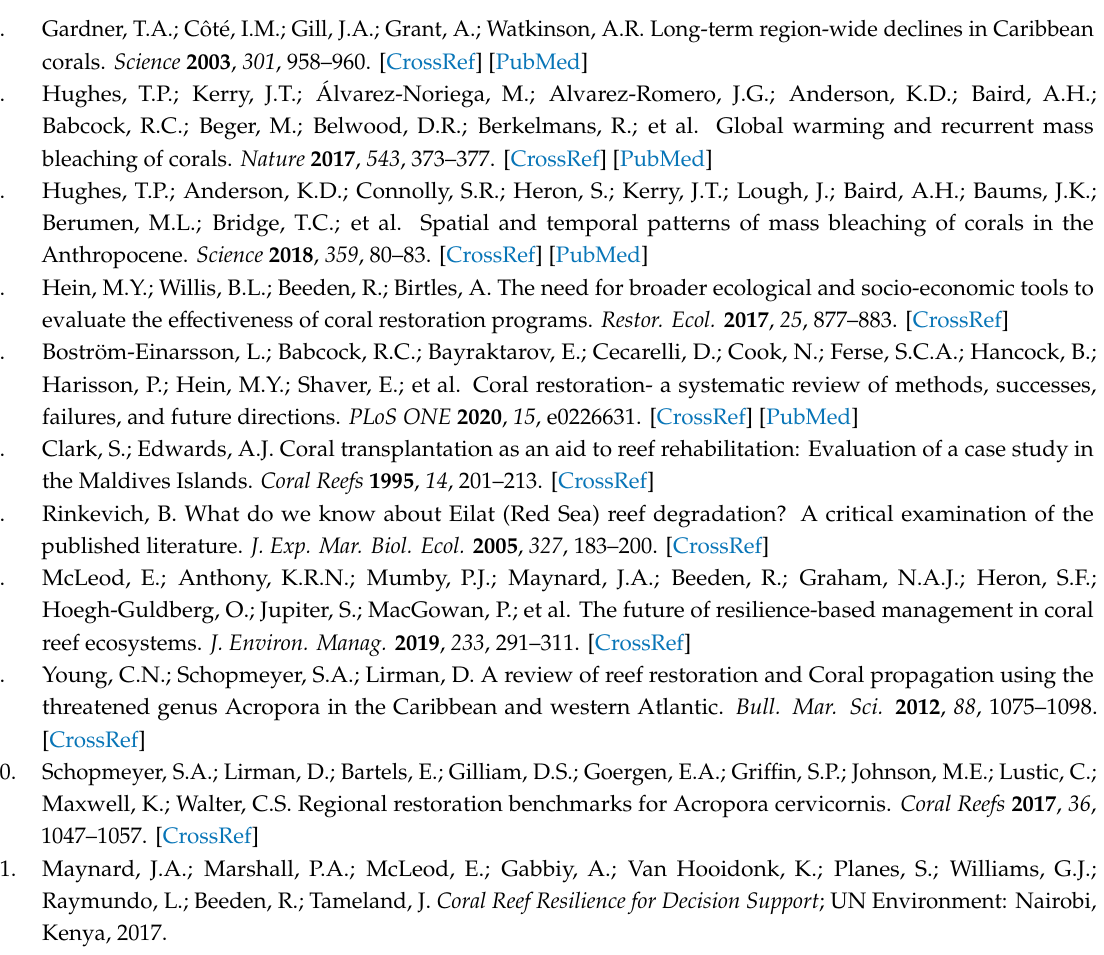
Table S1. Hard coral cover among treatments Posthoc with Tukeys’ contrast on linear models, Table S2.